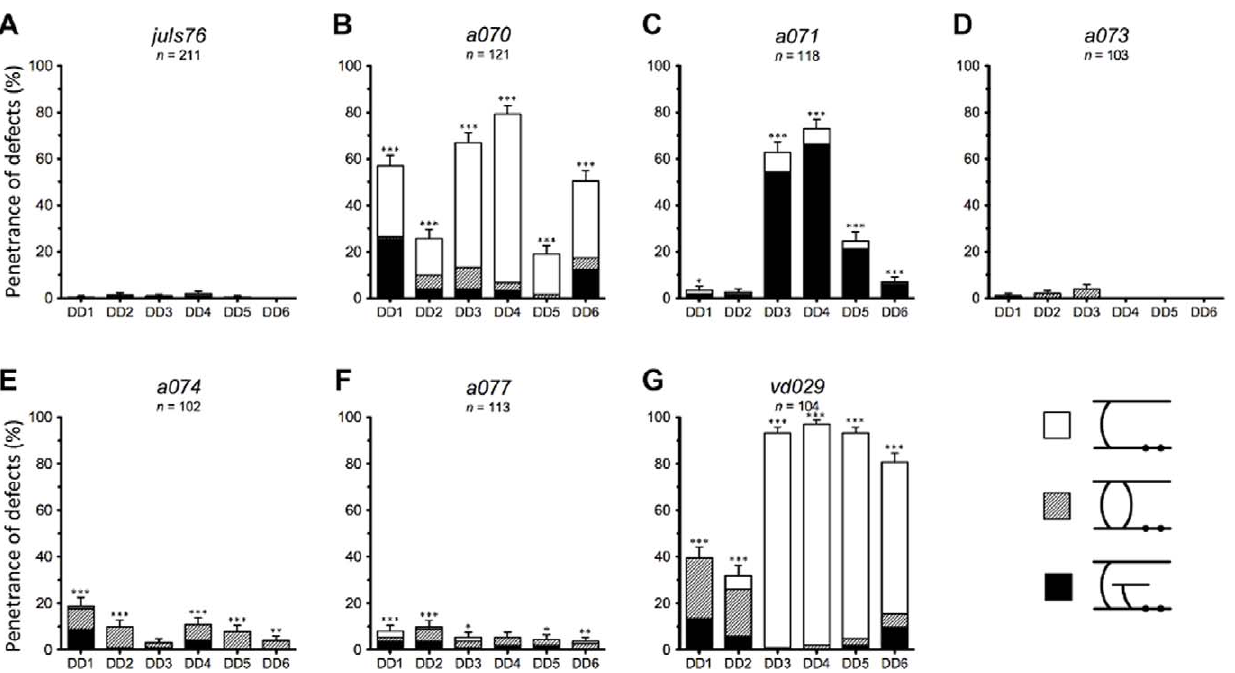
Figure 6. Cell specific characterization for L1 animals. (A–G) Penetrance of defects in each DD neuron for wild-type ( juIs76 ) and isolated alleles. Asterisks indicate statistical significance of combined phenotypes per cell compared to wild-type. Single, double, and triple asterisks indicate p , 0.05, p , 0.01, and p , 0.001, respectively. Statistical significance determined using chi-squared test. Number of animals examined for each allele labeled in graph. Error bars represent standard error of proportion for sum of phenotypes per cell.